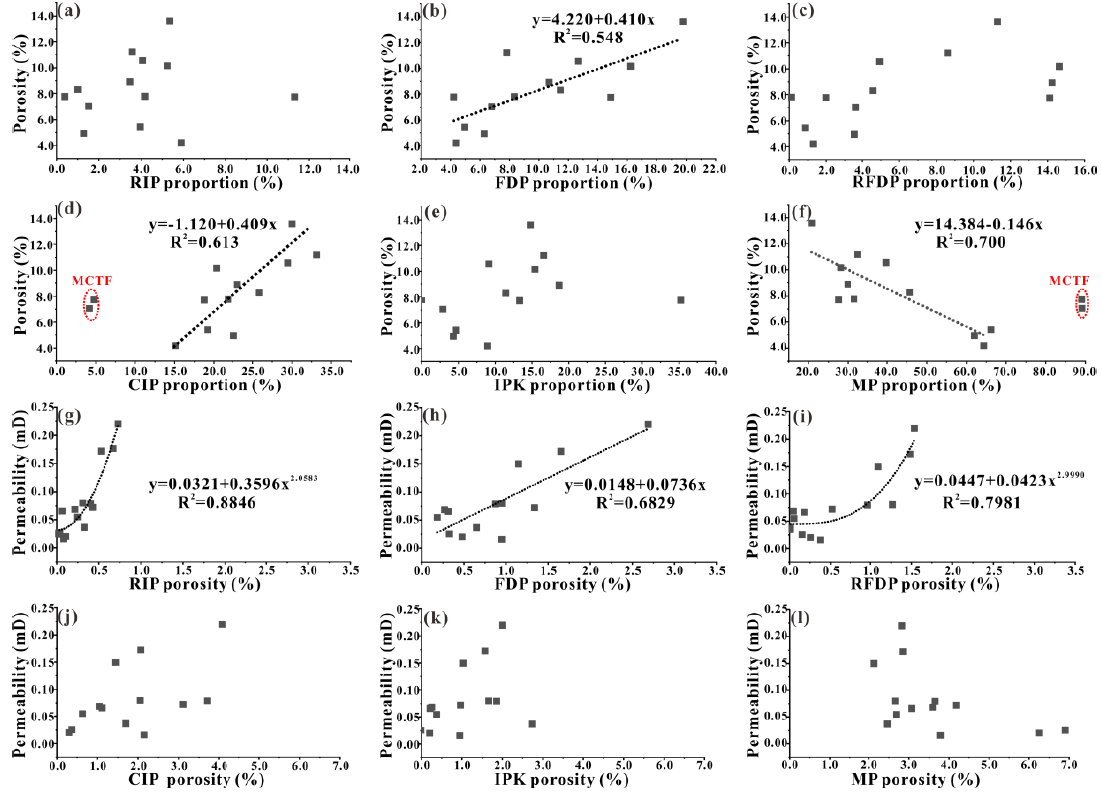
Figure 11. The relationship between the petrophysical properties and the proportions of different pore types. ( a – f ) Porosity vs. the proportions of RIP, FDP, RFDP, CIP, IPK, and MP; ( g – l ) permeability vs. types. ( a )–( f ) Porosity vs. the proportions of RIP, FDP, RFDP, CIP, IPK, and MP; ( g )–( l ) permeability the proportions of RIP, FDP, RFDP, CIP, IPK, and vs. the proportions of RIP, FDP, RFDP, CIP, IPK, and MP.